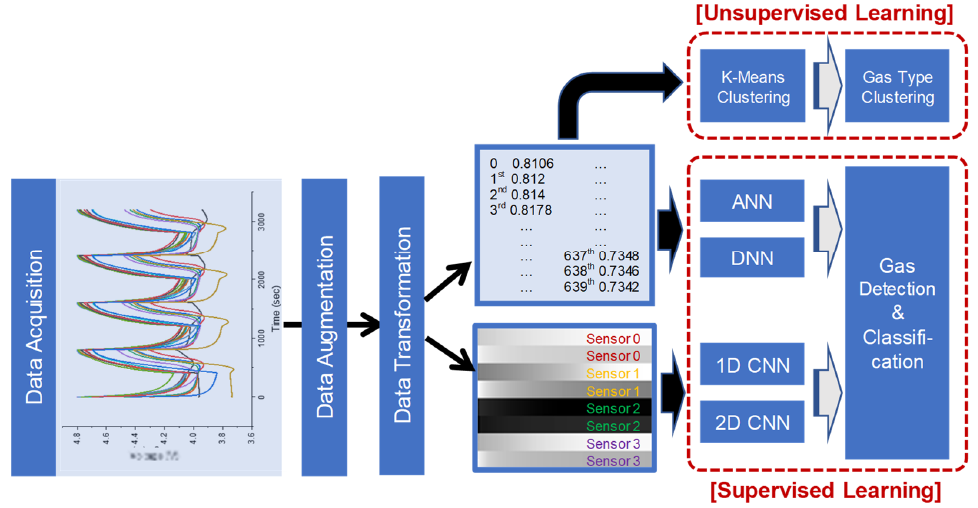
Figure 1. Machine learning approaches for gas classification that incorporate unsupervised learning via K-means clustering and supervised learning algorithms, namely, ANN, DNN, 1D CNN, and 2D